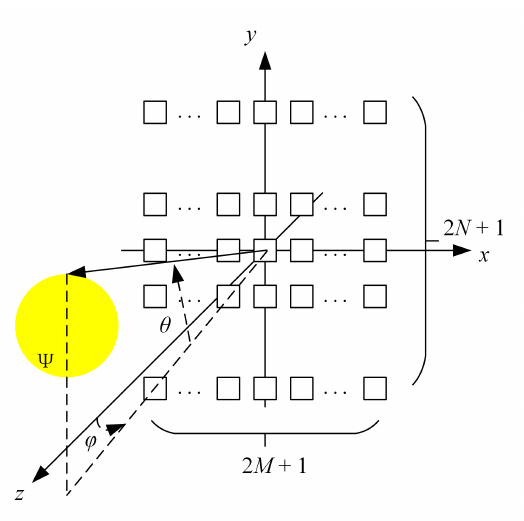
Figure 2. Array structure of phased array and frequency diverse array. The difference between a phased array and an FDA is the carrier frequency of each element. In a phased array, each element radiate the same carrier frequency, whereas FDAs apply an additional frequency shift across the array elements. More specifically, the carrier frequency of each element in a phased array and an FDA are designed as (1) and (2),